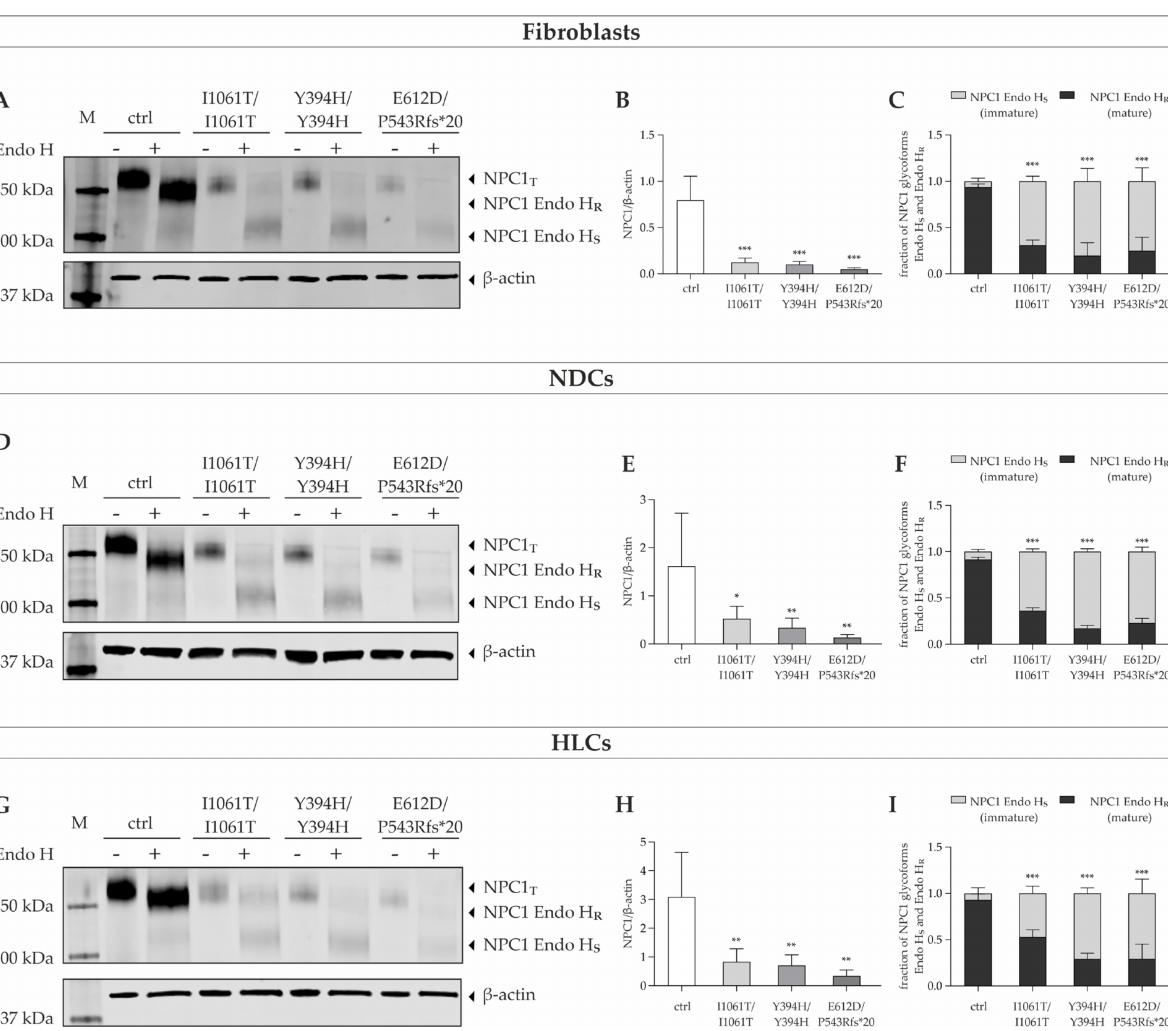
Figure 3. NPC1 expression in patients’ fibroblasts, neural differentiated and hepatocyte-like cells. ( A , D , G ) Western Blot analysis was performed to determine total NPC1 protein and maturation of NPC1 protein by digestion of the samples with endoglycosidase H in primary fibroblasts, NDCs, and HLCs, respectively. The fluorescence intensity of NPC1 band signals was normalized against the fluorescence intensity of β -actin band signals, which was used as a reference protein. ( B , E , H ) Quantification of the NPC1 band signals observed from the undigested samples demonstrated a significantly reduced amount of total NPC1 protein in all NPC1-deficient cell lines in comparison to the control cell line. N = 4–6. ( C , F , I ) Determination of the NPC1 glycoforms in patients’ fibroblasts, NDCs, and HLCs, respectively. The Endo H-resistant and Endo H-sensitive glycoforms of NPC1 protein are indicated as a fraction of total NPC1 (Endo H R + Endo H S ). Control cells predominantly show Endo H-resistant (Endo H R ) NPC1 protein, while mutant NPC1 protein is mainly present in Endo H-sensitive (Endo H s ) form, indicating retention in the ER. N = 6. * = p < 0.05, ** = p < 0.01, *** = p < 0.001 by one-way ANOVA, followed by the Dunnett’s post hoc test compared to ctrl. NDCs = neural differentiated cells; HLCs = hepatocyte-like cells; NPC1 T = total NPC1 protein; Endo H = Endoglycosidase H; Endo H R = Endo H-resistant; Endo H S = Endo H-sensitive; M = size